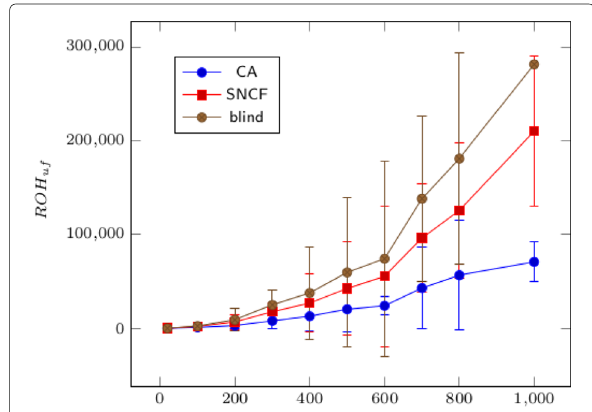
Fig. 20 Total number of redundant frames received in the network ( ROH uf ) until the destination is reached for blind, SNCF, and CA protocols in ideal wireless